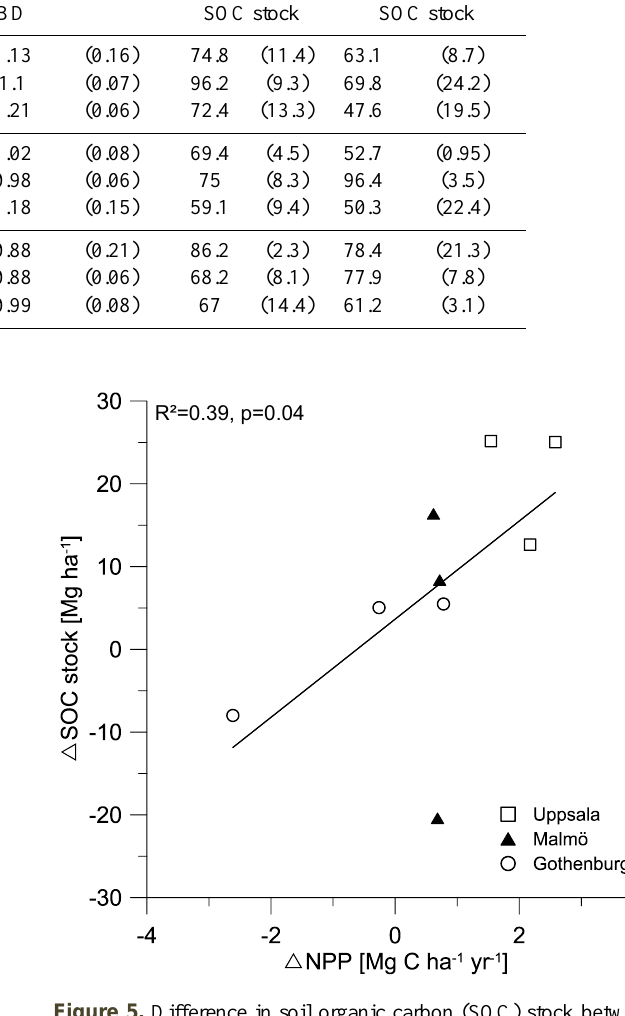
Figure 4. Bar plot showing measured soil organic carbon (SOC) concentration in the two different lawn types at each site. Error bars indicate standard deviation and stars indicate significant difference between treatments at the specific site ( p <0.05).